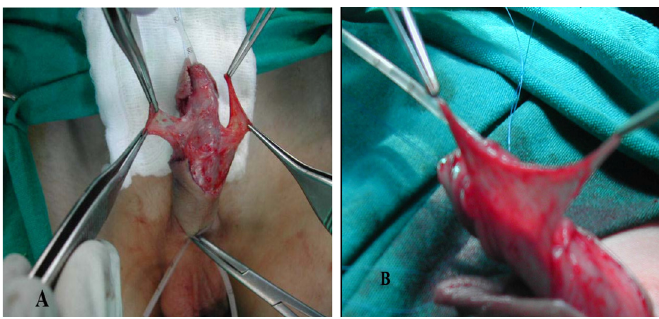
FIGURE 2 - A. Double dartos flap coverage of proximal neourethra in progress. B. Ventral transposition of the longitudinal dorsal dartos